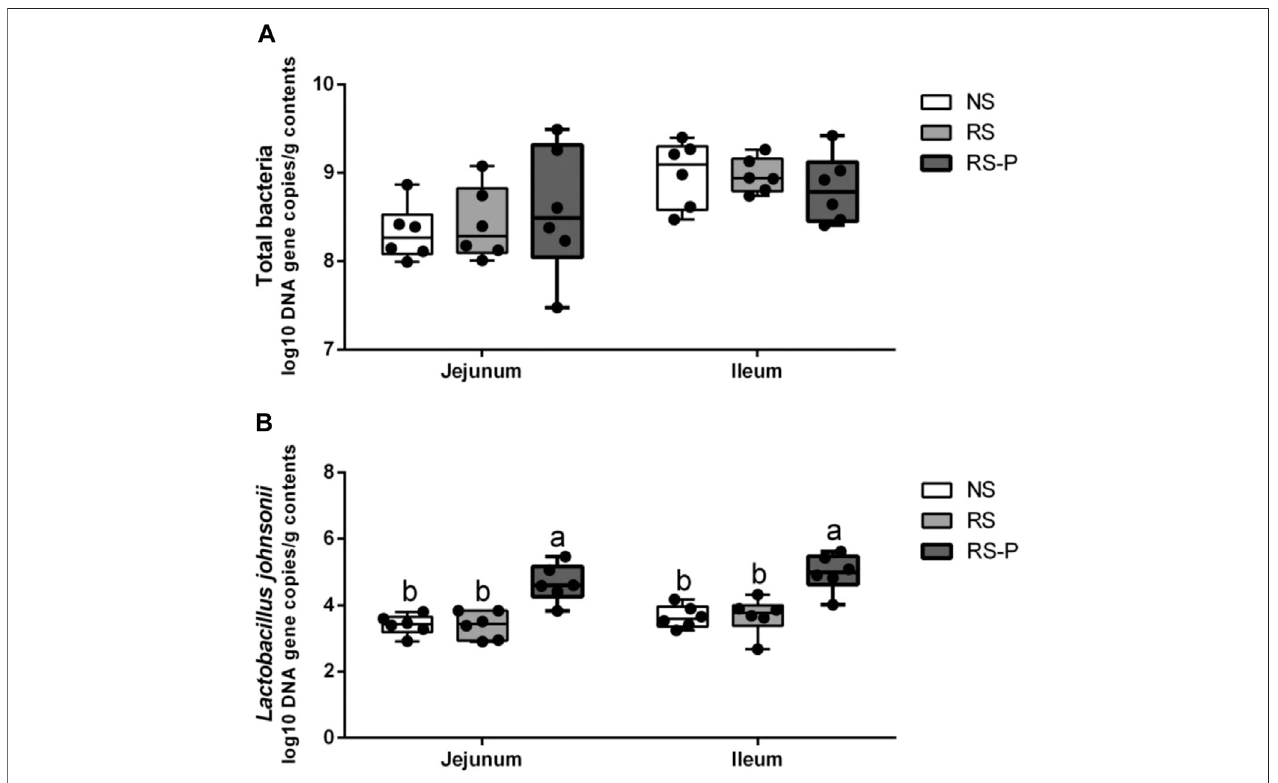
FIGURE 14 | Log10 DNA gene copies of total bacteria (A) and Lactobacillus johnsonii (B) as quanti fi ed by quantitative PCR in the jejunum and ileum. Data are presented with the means ± standard deviation ( n (cid:2) 6). Bars with different letters are signi fi cantly different on the basis of Duncan ’ s multiple range test ( P < 0.05).